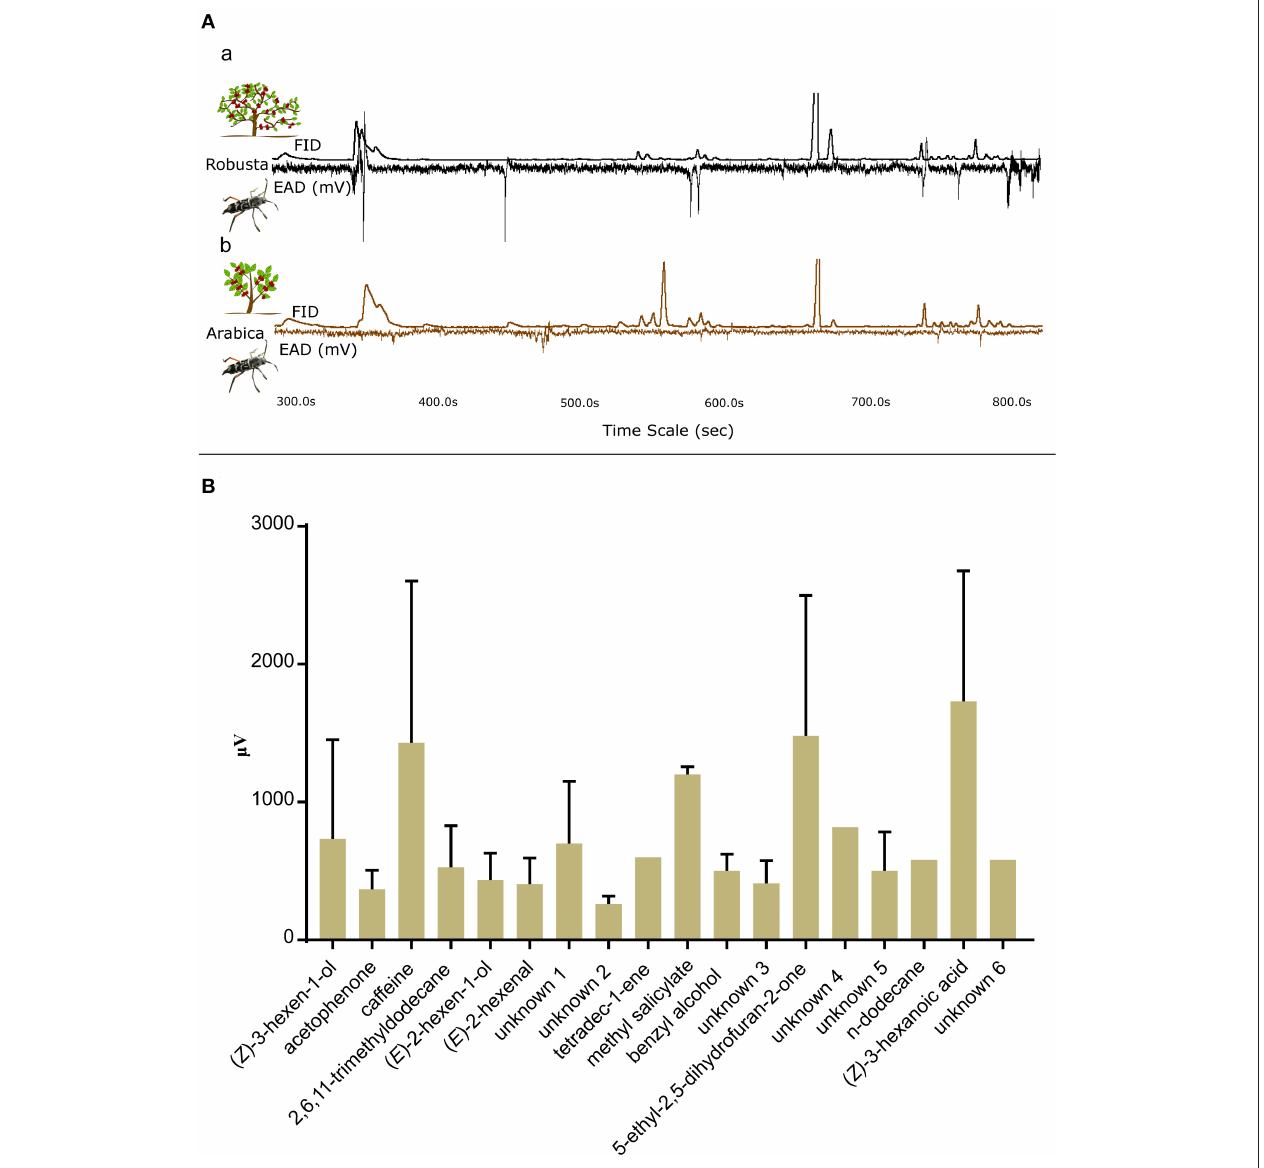
FIGURE 3 | Gas Chromatography—electroantennographic detection (GC-EAD) responses of CWSB. (A) GC-EAD traces with Flame Ionization Detector (FID) peaks and electroantennographic (EAD) responses of CWSB for hexane extracts of robusta (a) and arabica (b). (B) GC-EAD responses of male and female CWSB for different compounds of arabica and robusta hexane leaf extracts identified in Table 1 ( n values of male and female for each compound listed in Supplementary Table 5 ). µ V, microVolt; FID, Flame Ionization Detector; EAG,